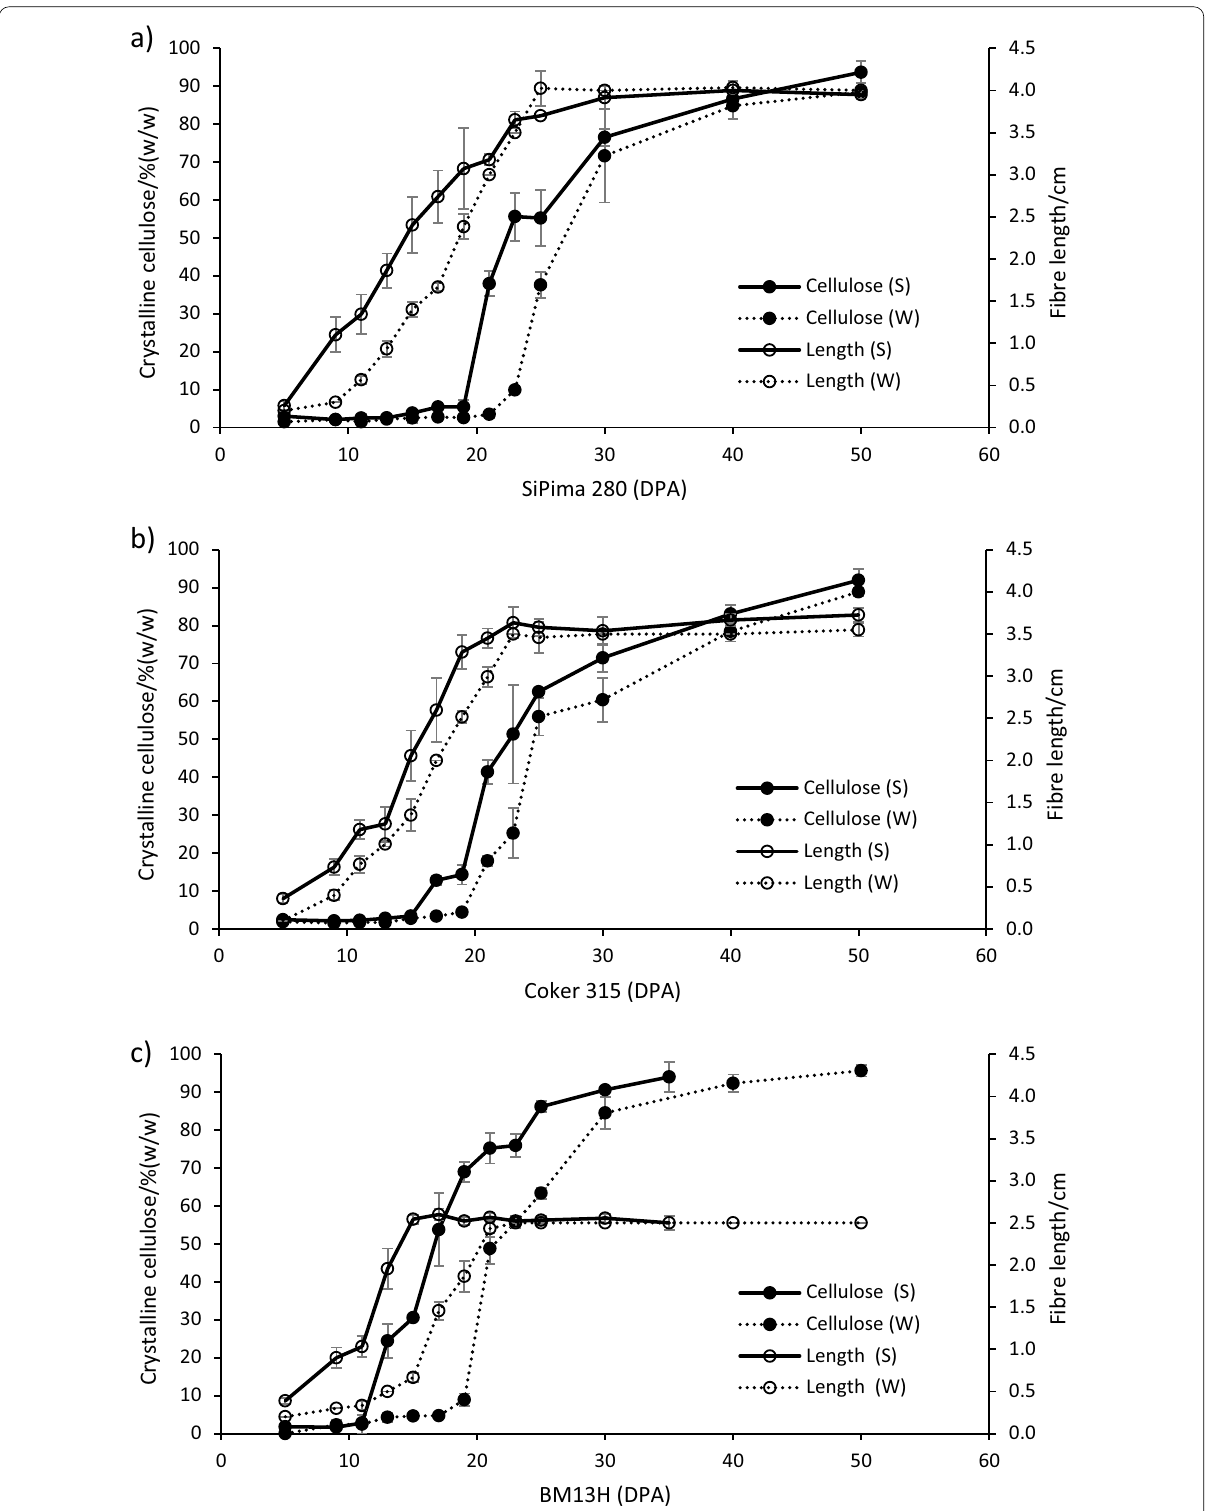
Fig. 2 Changes in fibre length (cm) and crystalline cellulose [% (w/w)], through development for a SiPima 280 ( G. barbadense ), b Coker 315-11 ( G. hirsutum ) and c BM13H ( G. arboreum ) cotton varieties over different seasons (W, winter; S,